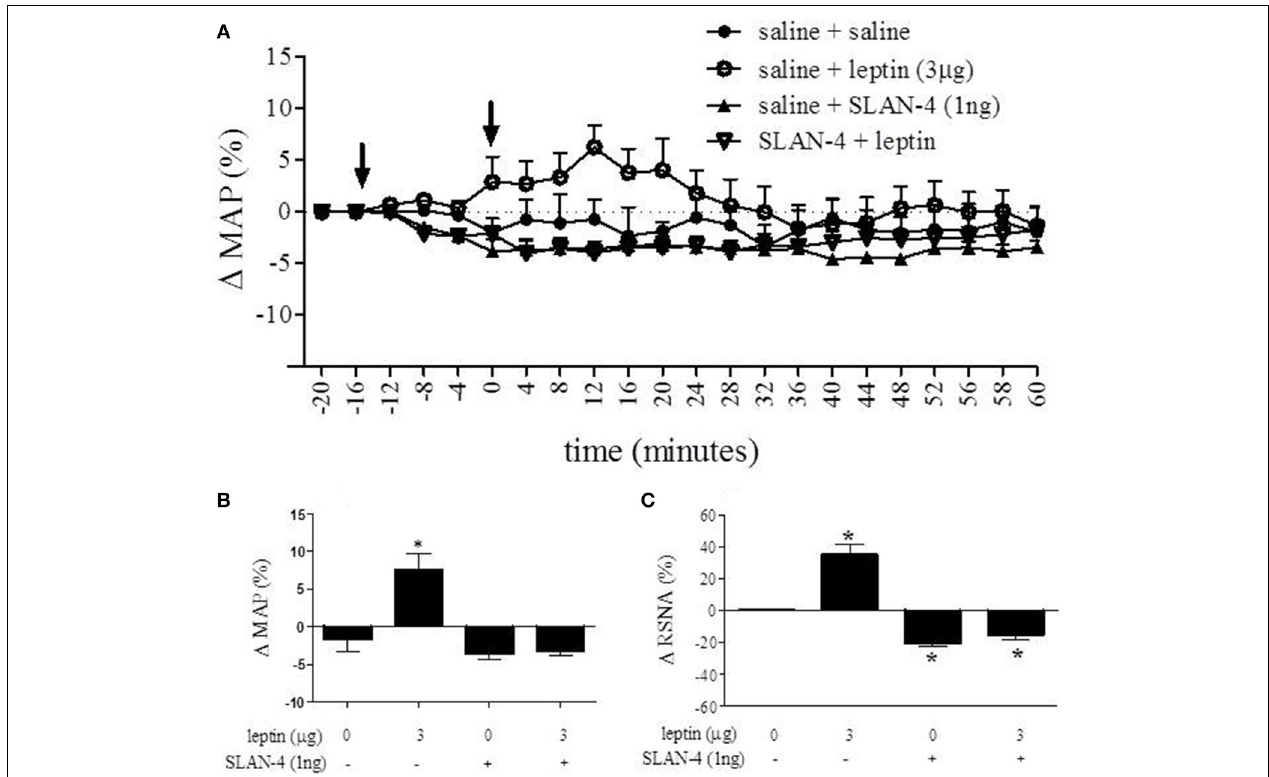
FIGURE 5 | Nano-injection of rat superactive leptin antagonist (SLAN-4) attenuated the leptin-induced increase in MAP and RSNA and decreased basal RSNA. Time course response of MAP after administering leptin and SLAN-4 into the RVLM is presented in (A) . 12min following the second injection, MAP was increased following saline + leptin relative to saline +